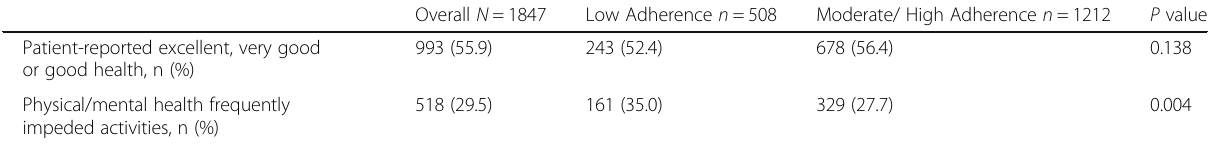
Table 1 Demographics of survey respondents by level of comorbidity medication adherence (Continued) Overall N = 1847